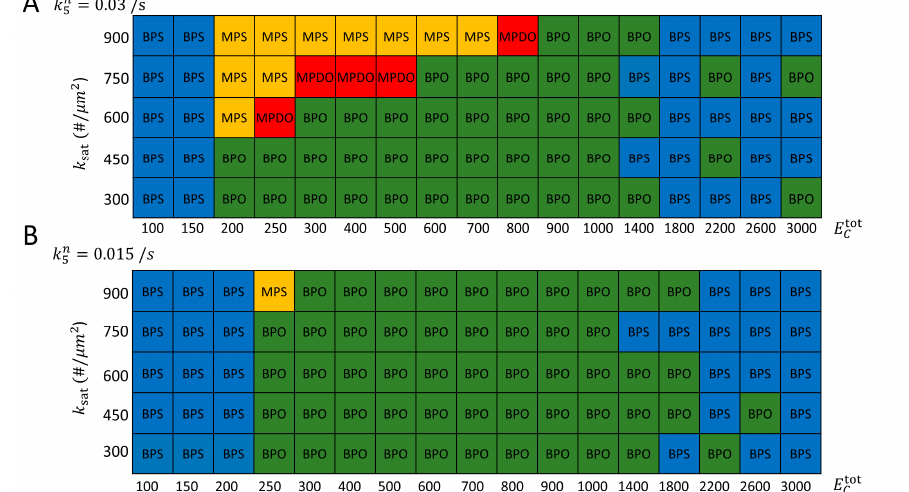
Figure 5. Structure of dynamical states reached, as function of total GEF amount ( E tot ) and negative feedback parameter k sat . Results show the final state reached by a single simulation for each set of parameters over time course of 800–1200 s, starting from an unpolarized state. Other parameters same as Table 1. ( A ) Reference simulations. For k sat = 600 − 900 / µ m 2 , the system can transition from MPDO to BPO with increasing E tot , a behavior consistent with the dynamical change observed under cell growth around NETO. ( B ) Same as panel A but reducing the rate of GAP II recruitment to the cell tips, as might occur in rga4 Δ or rga6 Δ cells. The BPO region is observed to expand compared to panel A, while the region corresponding to MPS and MPDO states shrinks.